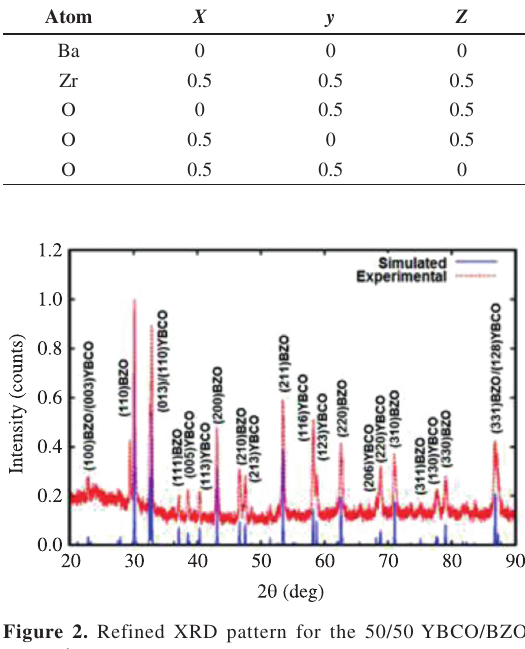
Figure 2. Refined XRD pattern for the 50/50 YBCO/BZO